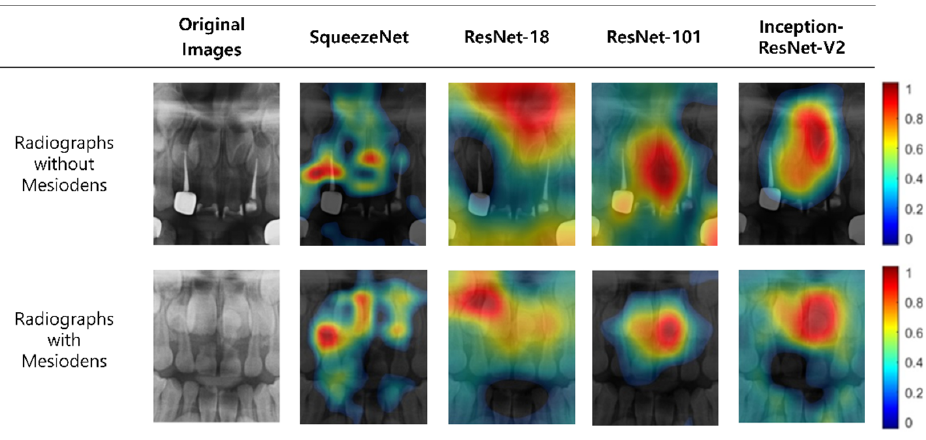
Figure 4. Example of the class activation maps of four deep-learning models.